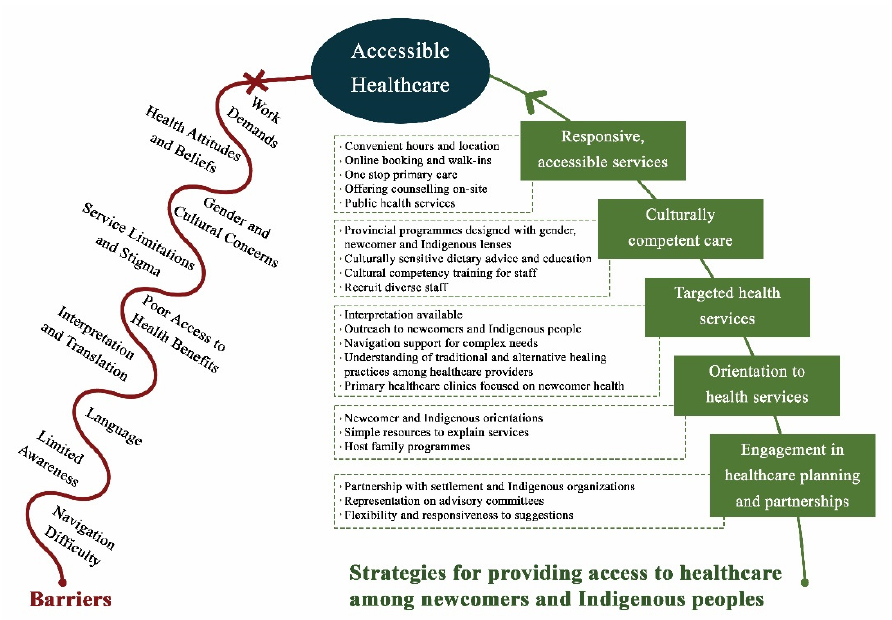
Figure 2. Strategies to support accessible healthcare.